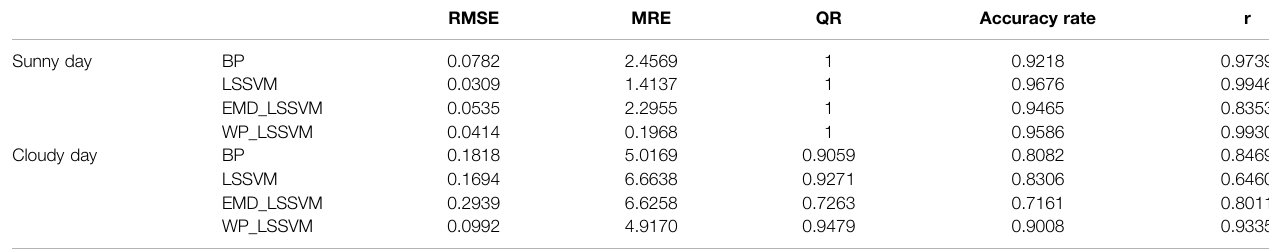
TABLE 2 | Comparison of prediction results obtained by fi ve models. Sunny day